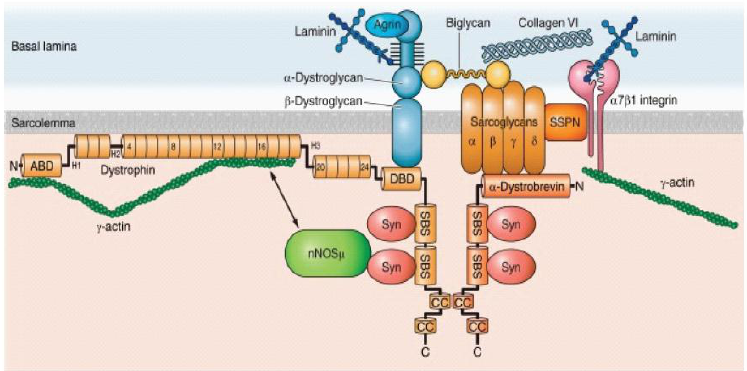
Figure 1. The dystrophin glycoprotein complex (DGC) in a skeletal muscle cell. Shown are the interactions among core components of the DGC, the extracellular matrix, and nNOS. Numbers in dystrophin indicate hinge regions (H1, H2, etc.) and spectrin-like repeat domains (4, 8, 12, etc.). However, nNOS is not associated with DGC in a cardiomyocyte (see the text for detail). nNOS, neuronal nitric oxide synthase; Syn, syntrophin; SSPN, sarcospan; ABD, actin binding domain; DBD, dystroglycan binding domain; SBS, syntrophin binding site; CC, coiled-coil domain; N, amino terminus; C, carboxy terminus. Obtained from Allen DG, Whitehead NP, and Froehner SC, “Absence